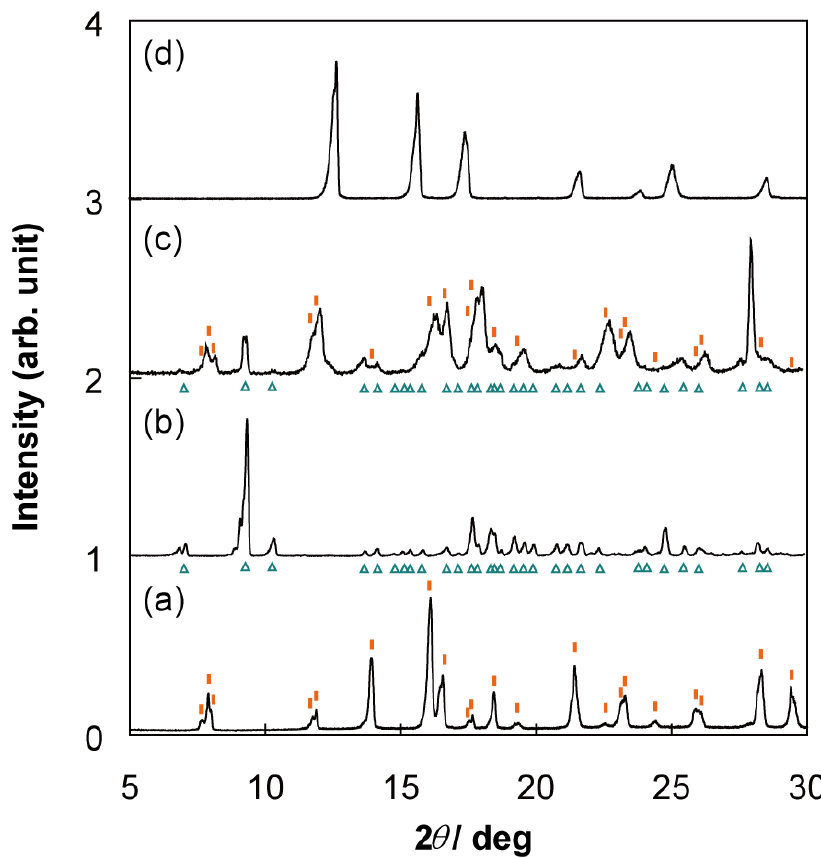
Figure 5. Powder X-ray pattern of [TPP/(TEMPOL) the co-precipitation method [32] (a) , TPP monoclinic phase recrystallized from mesitylene (b) , compound 2 (c) , and bulk TEMPOL (d) . The typical peak positions of (a) or (b) were depicted with red vertical bars on (a) or cyan triangles under (b) , respectively. The powder pattern of (c) was almost interpreted as a superposition of that of (a) and (b) . The peaks corresponding to the bulk TEMPOL in (d) were hardly observed in (c)